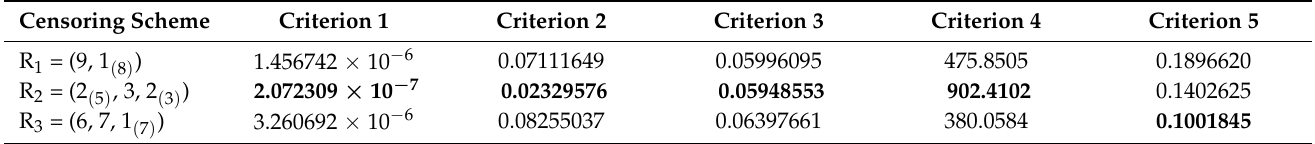
Table 12. Selection of optimum censoring scheme based on different